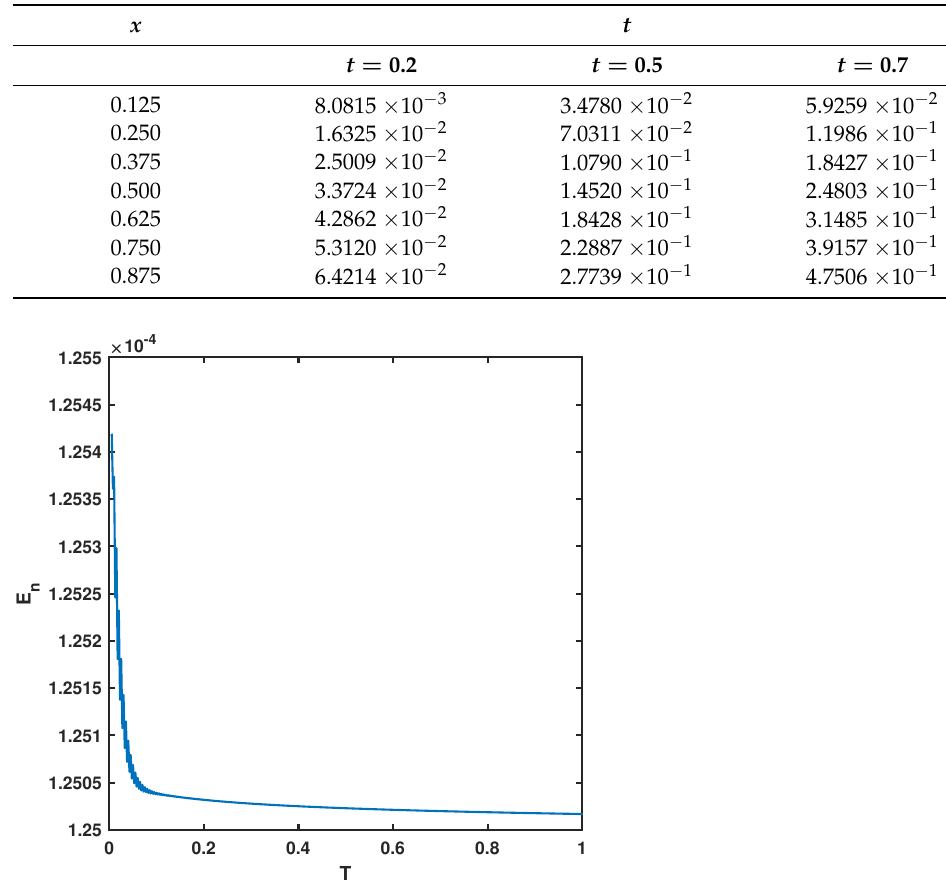
Table 5. The numerical solution for Example 5, where τ = 0.1, c = 10, α = 2, ν = 1, K = 180, M = 52, and N = 12.